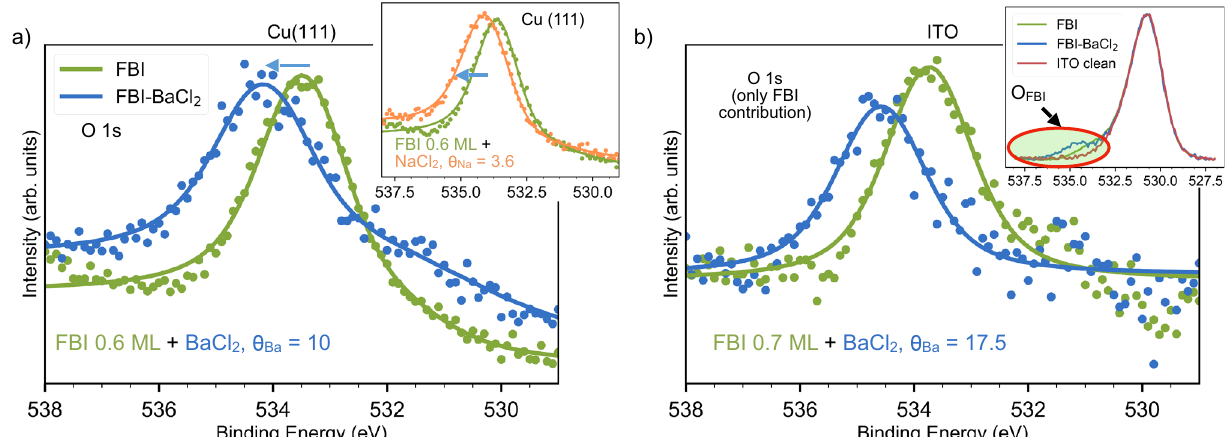
Fig. 5 | O 1 s core level evolution upon chelation measured on two sub- monolayer FBI-functionalized surfaces. a chelation on Cu(111) sublimating BaCl 2 and NaCl (inset); b chelation on ITO. In this case, the substrate component (O ITO )